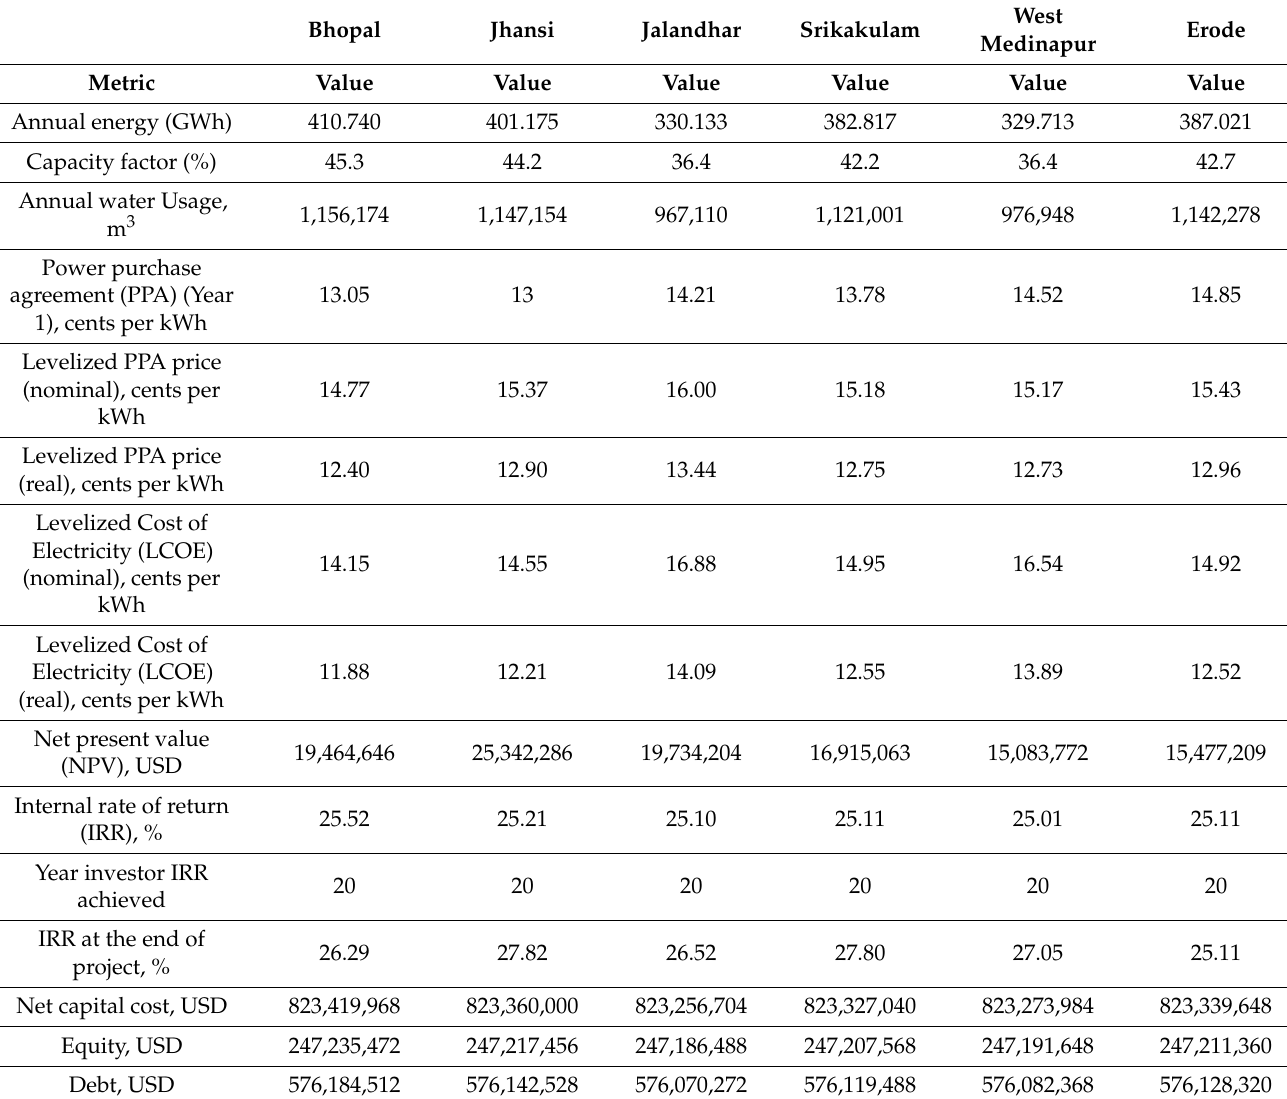
Table 3. Economic results from the simulation in SAM for the STPP (wet-cooled)